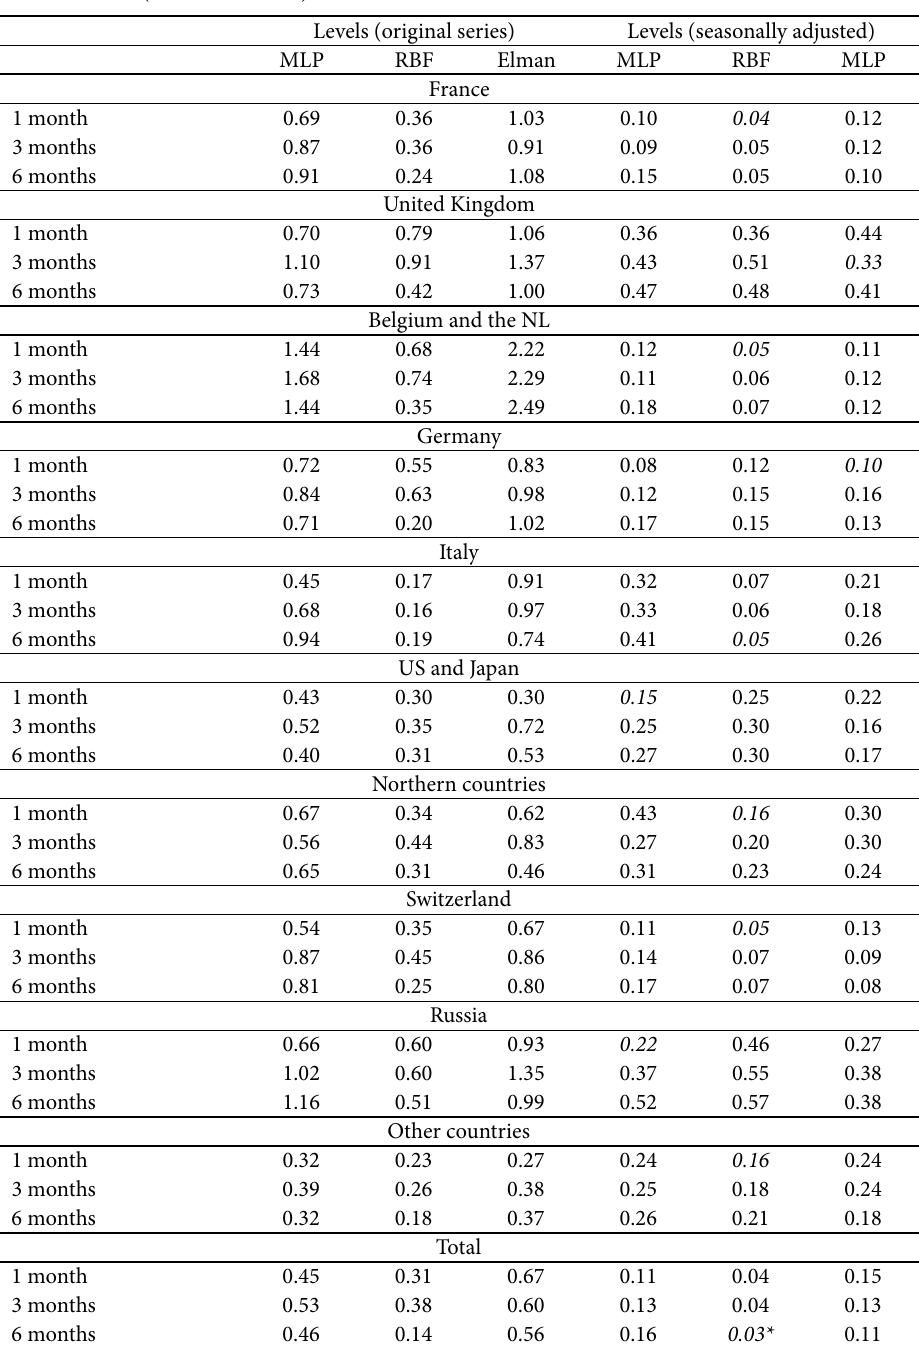
Table 3. MAPE (2010:04–2012:02) Levels vs. SA Levels Levels (original series) Levels (seasonally adjusted) MLP RBF